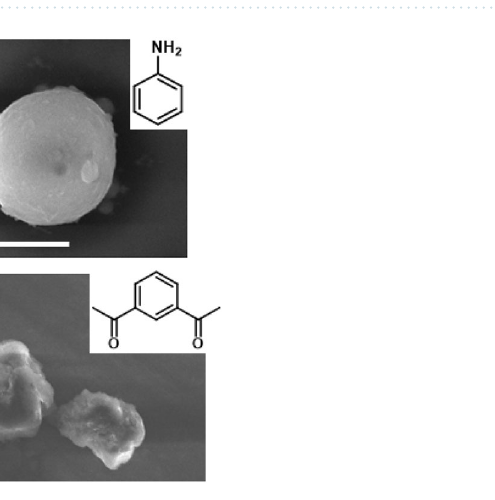
Figure 1. Top: Cartoon depicting ligand exchange at QD surface. Bottom ( A – C ): SEM images of QD shells formed using BIP-Me, BIP-H and BIP-IPr, respectively. Ligand structures are shown to the left. All scale bars are 200 nm.